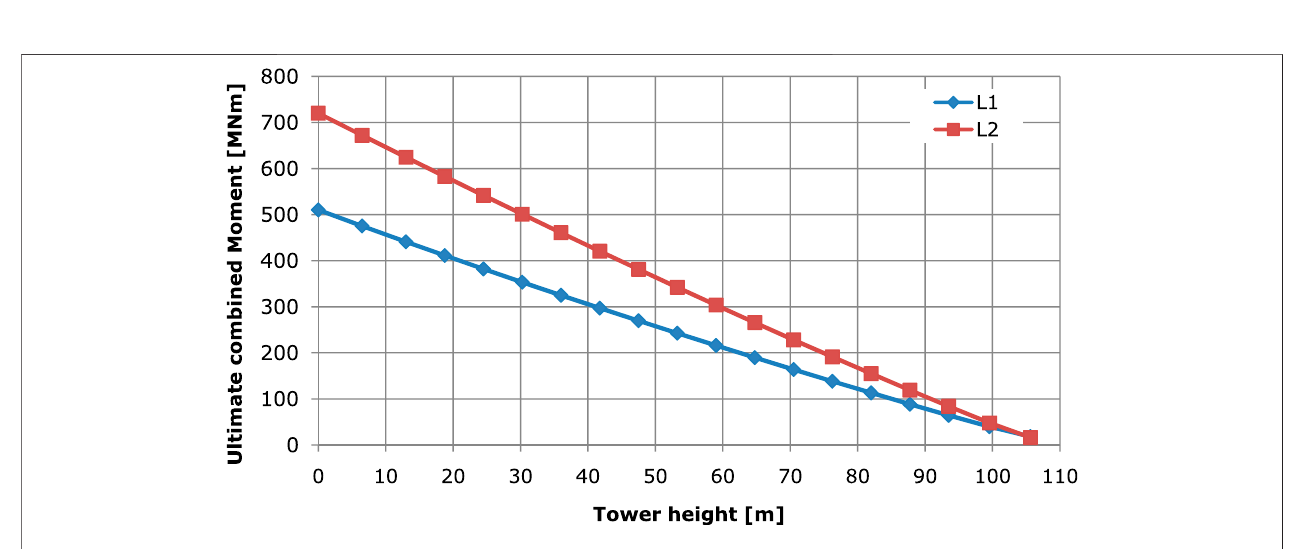
FIGURE 14 | Ultimate combined moment distribution along the tower span at L1 and L2 locations.